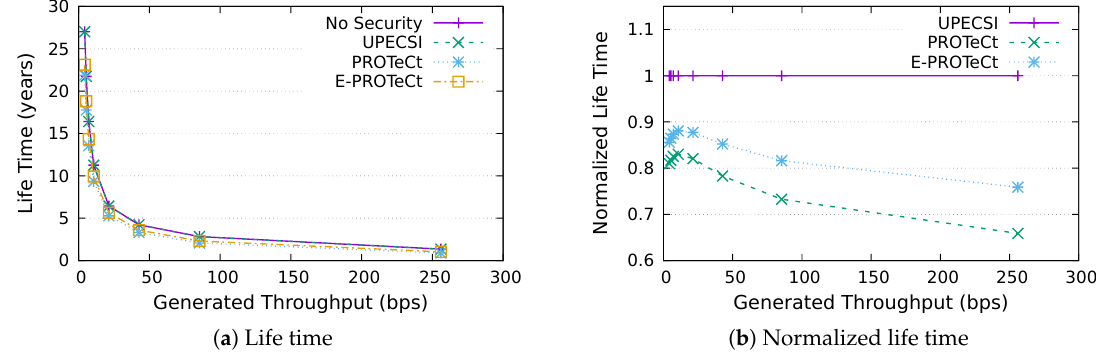
Figure 20. Life time analysis for an IoT network with 16 devices.